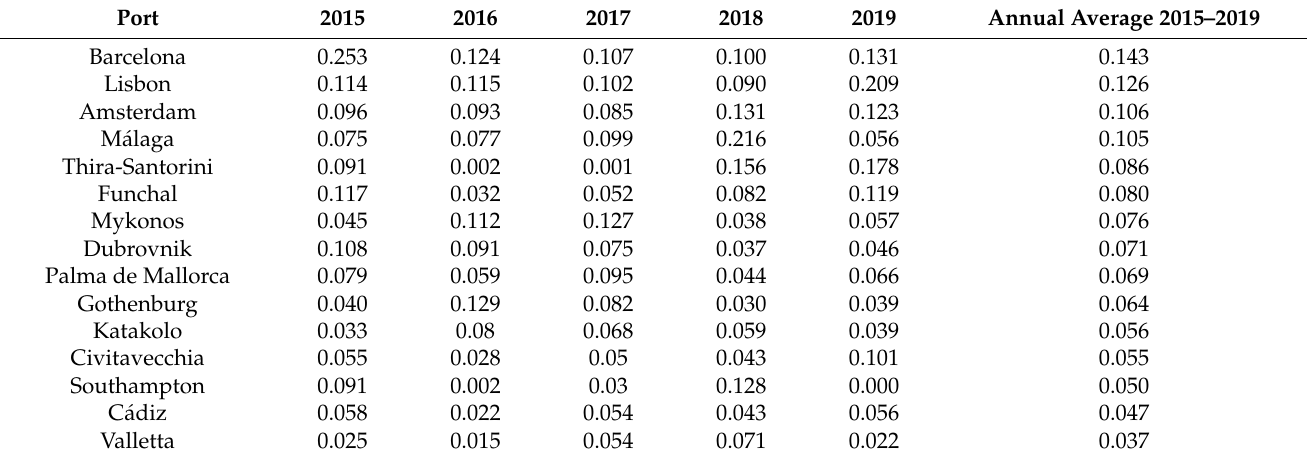
Table 8. Top 15 ports in terms of betweenness centrality and its evolution from 2015 to 2019 in the contemporary cruise port network in Southern